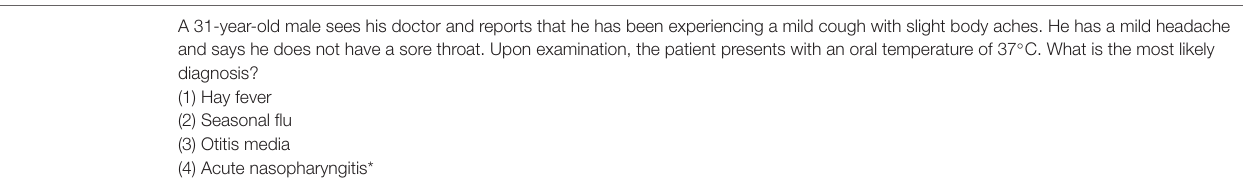
TABLE 1 | Medical item model